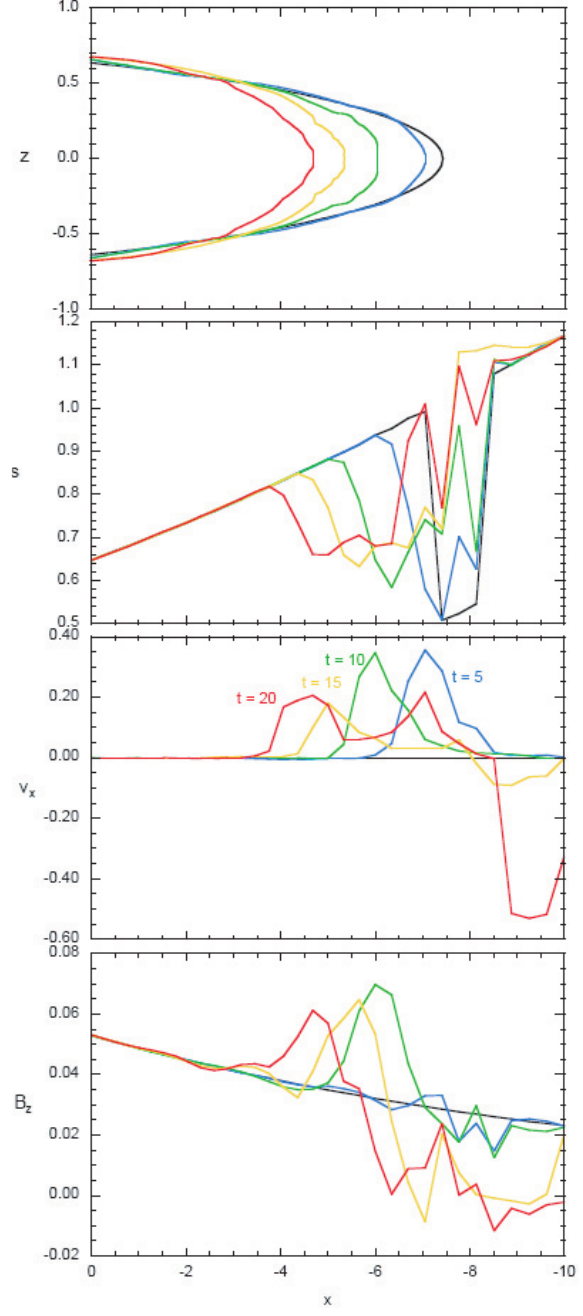
Fig. 38. Evolution of plasma-depleted tube with time in the numer- ical simulation of a plasma bubble. The bubble is easier to identify based on the depletion the entropy function s = p 1 /γ /ρ The upper panel shows the motion and reconfiguration of flux tube at the inner edge of the bubble. Other panels show the evolution of entropy, flow velocity and magnetic field B z -component in the equatorial plane. T=20 corresponds to approximately 8min of real time. (From Birn et al.,